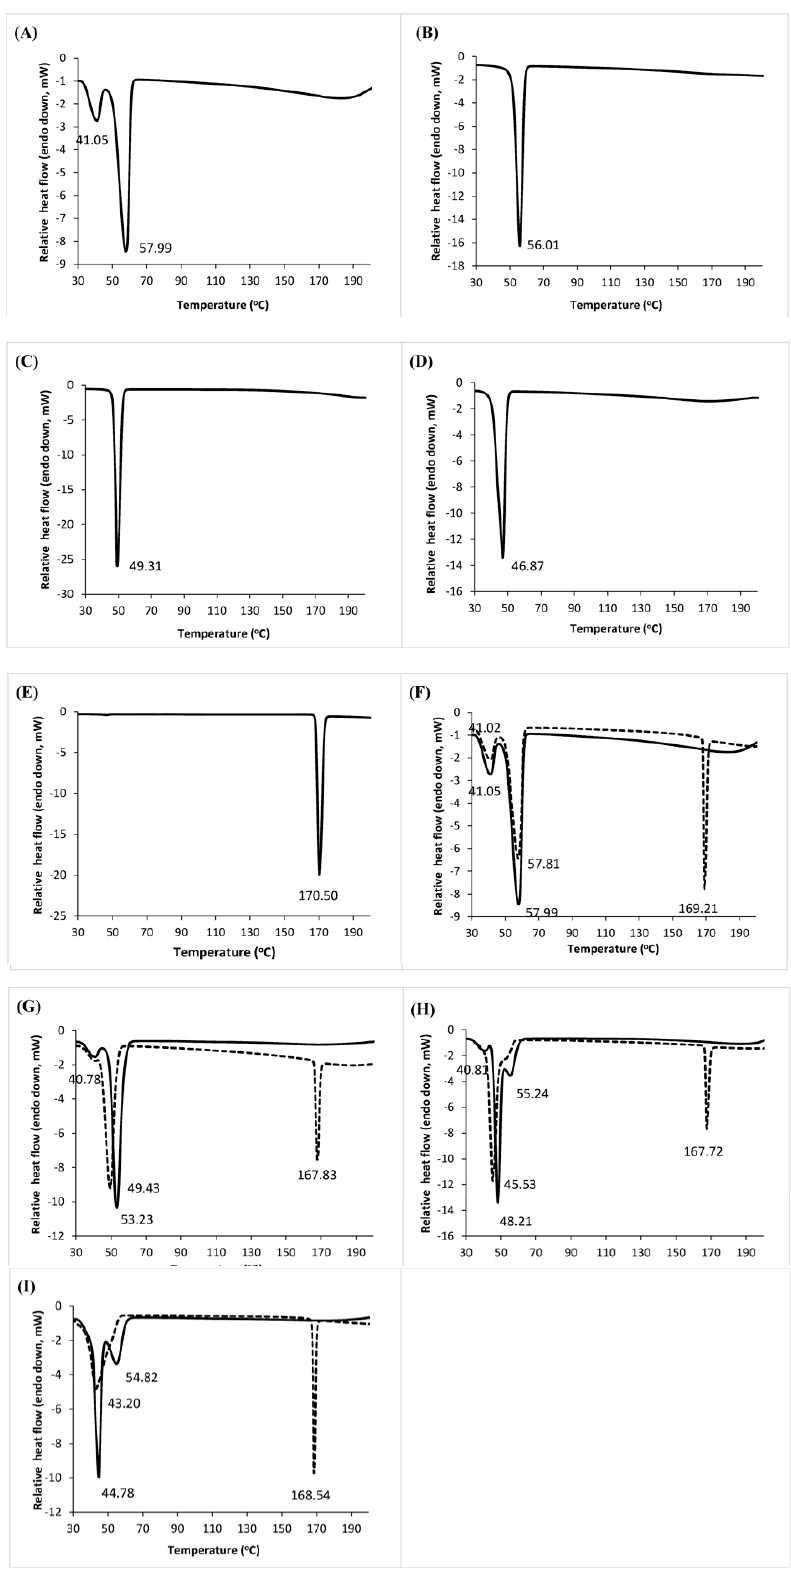
Figure 6. DSC thermograms of ( A ) PW59 unprocessed matrix; ( B ) SA unprocessed matrix; ( C ) CA unprocessed matrix; ( D ) CE unprocessed matrix; ( E ) paracetamol; ( F ) PW59; ( G ) PW59:SA (1:1); ( H ) PW59:CA (1:1); ( I ) PW59:CE (1:1). The dashed lines represent thermograms with 20% w / w paracetamol ( n = 3).